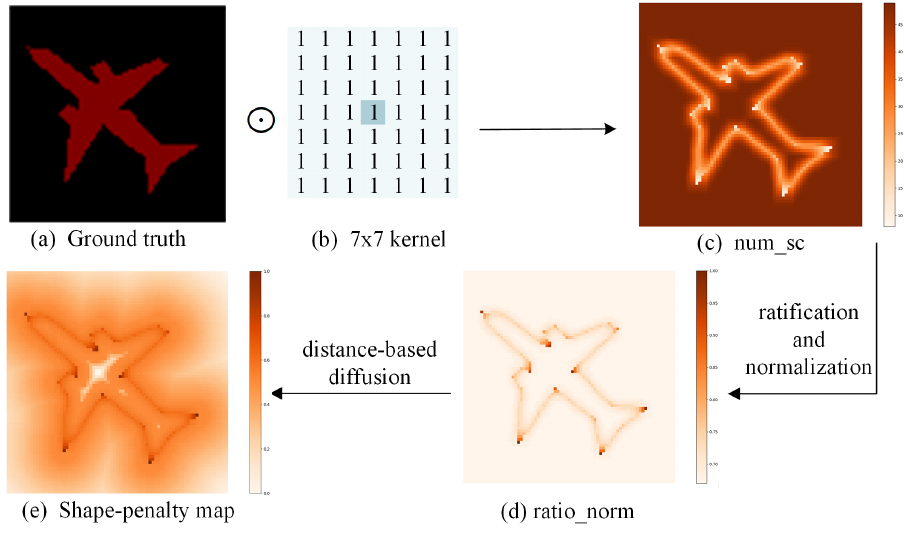
Figure 4. Shape-penalty map. ( a ) Ground truth label. ( b ) Convolution with a 7 × 7 kernel. ( c ) Number of pixels with the same category as the center. Note that the plane area (red region) and the background area (black region) are counted separately. ( d ) Ratio of different categories (num_dc) to the same categories (num_sc). ( e ) Shape-penalty map, in which the weights at sharp edges are larger than those at flat edges and in internal areas of an